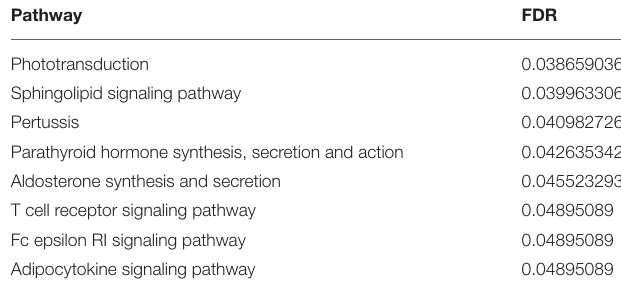
TABLE 2 | The KEGG pathways for the differential probes of methylation.